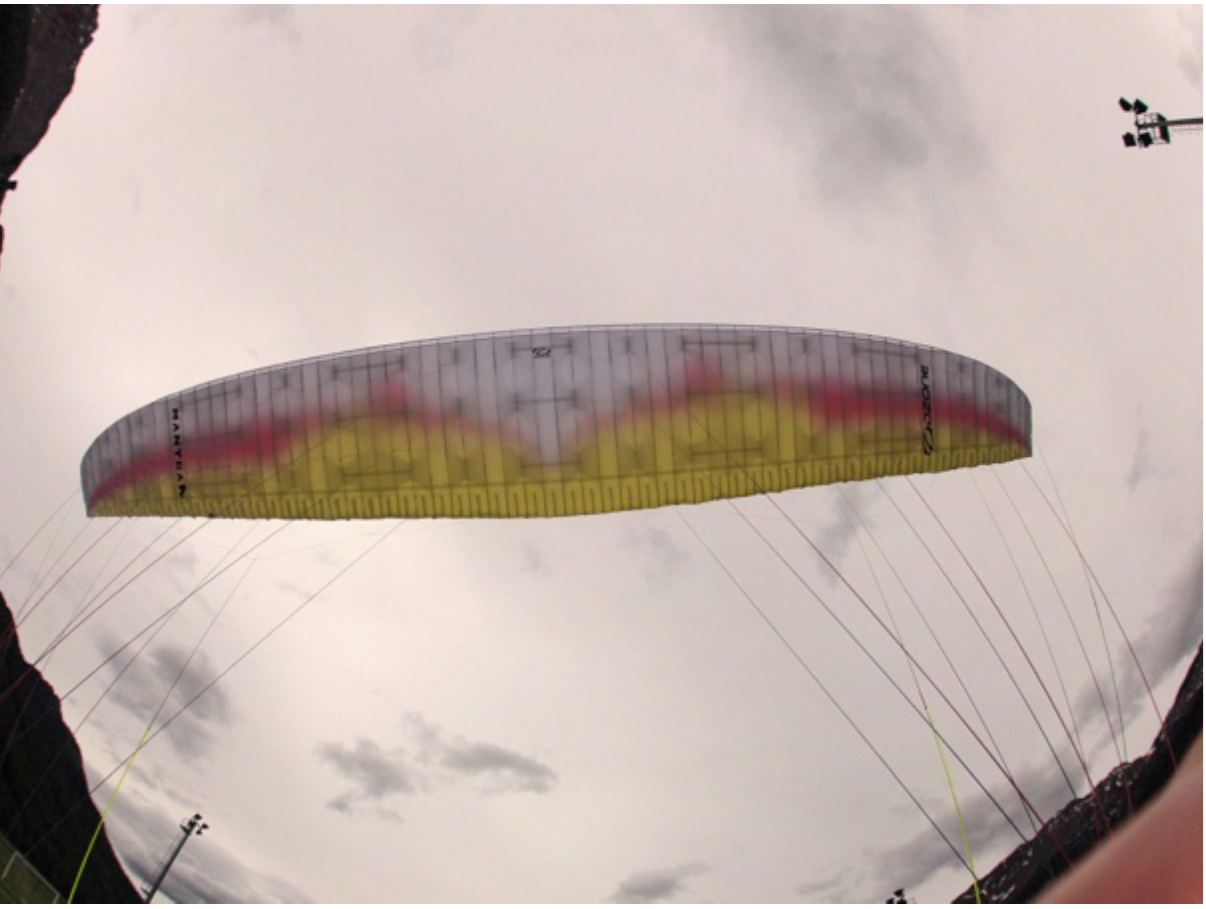
Fig.1: Pilot’s view of the